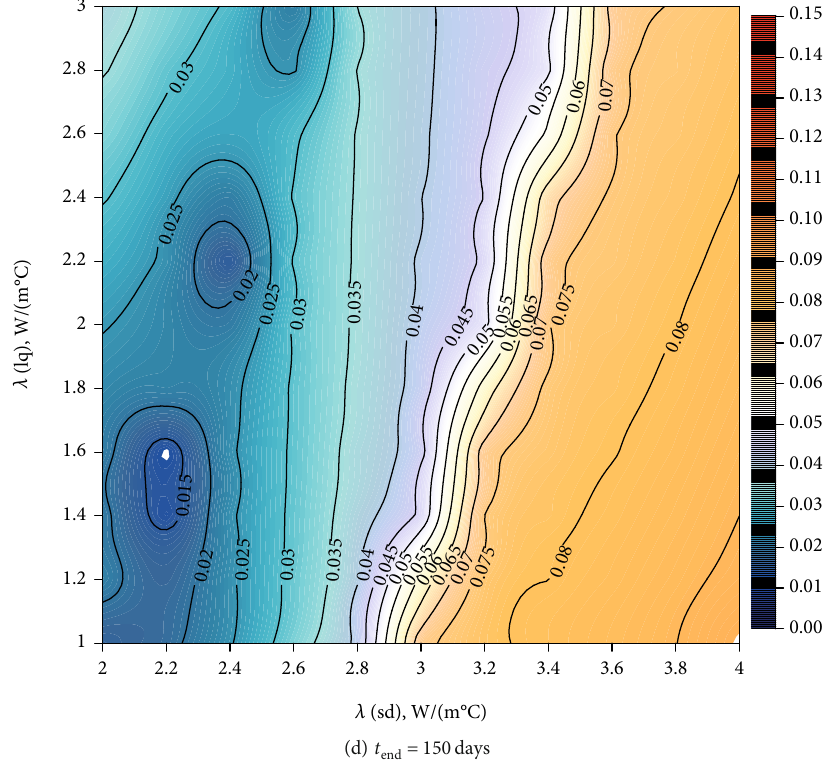
Figure 5: Isolines of the temperature discrepancy functional in the phase space of the adjustable parameters ( λ times for the chalk layer (shaft no.